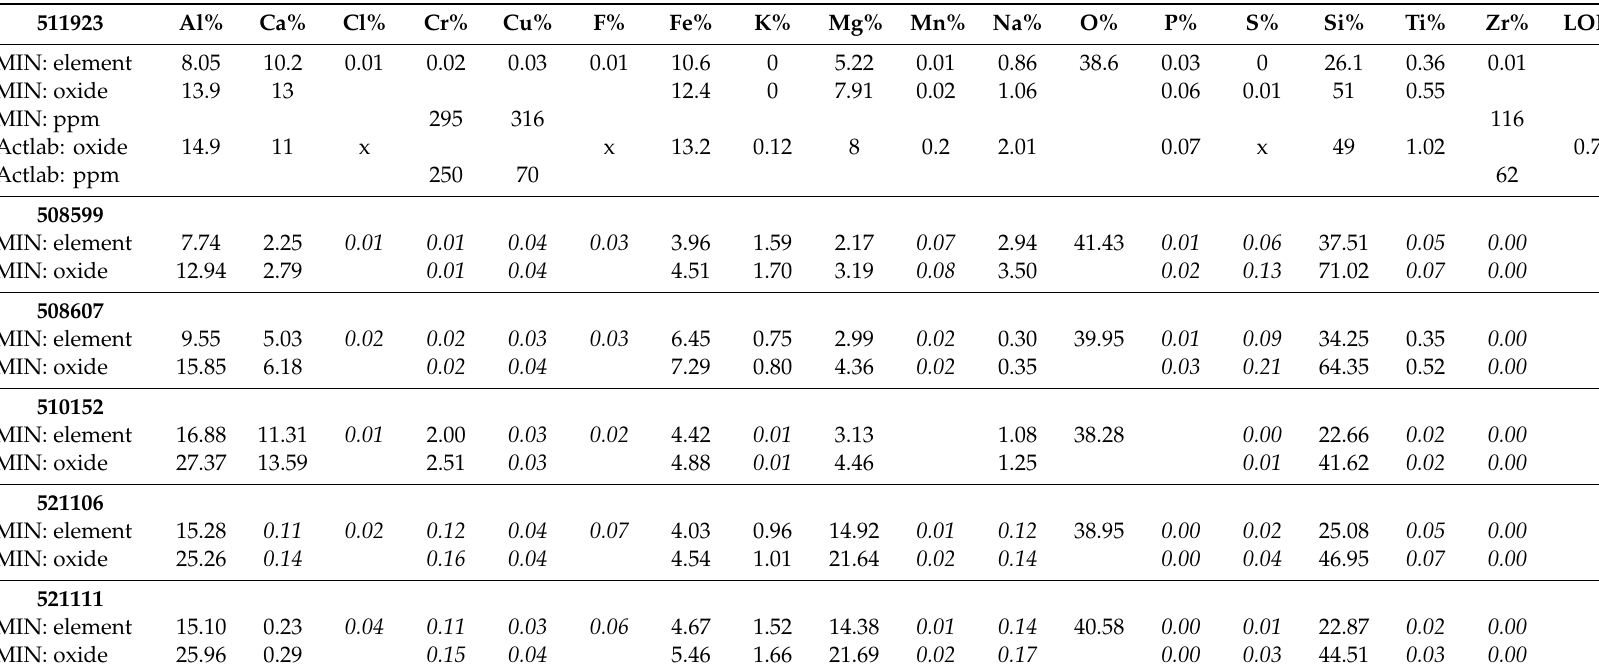
Table 2. Bulk geochemistry of each analysed thin section. For sample 511923, this data is compared to a whole rock geochemistry analysed by Actlab. Other data generated with Mineralogic (EDX analyses) in element wt% and recalculated to wt% oxides (and ppm for sample 511923). LOI: loss on ignition. Numbers in italics are estimates